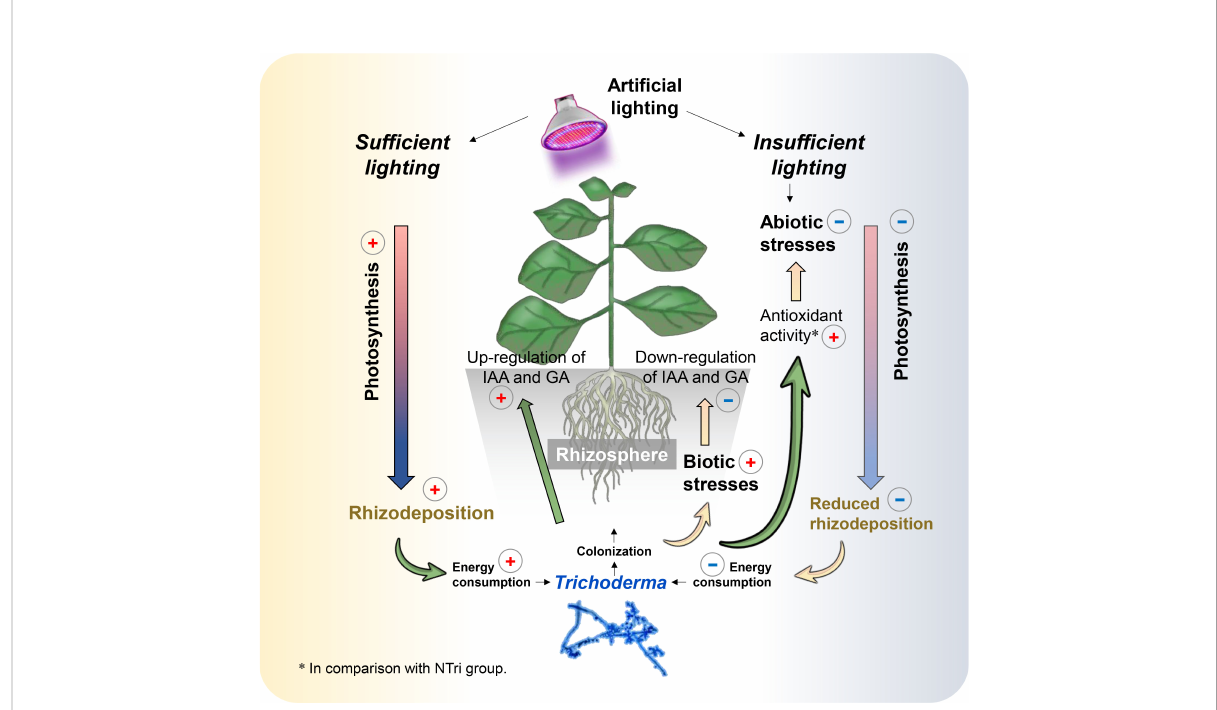
FIGURE 5 Schematic diagram of the interaction mechanism between arti fi cial light supply and Trichoderma inoculation revealed in this study. Arrows indicate in fl uence processes, positive red signs represent increase or enhancement, and negative blue signs represent